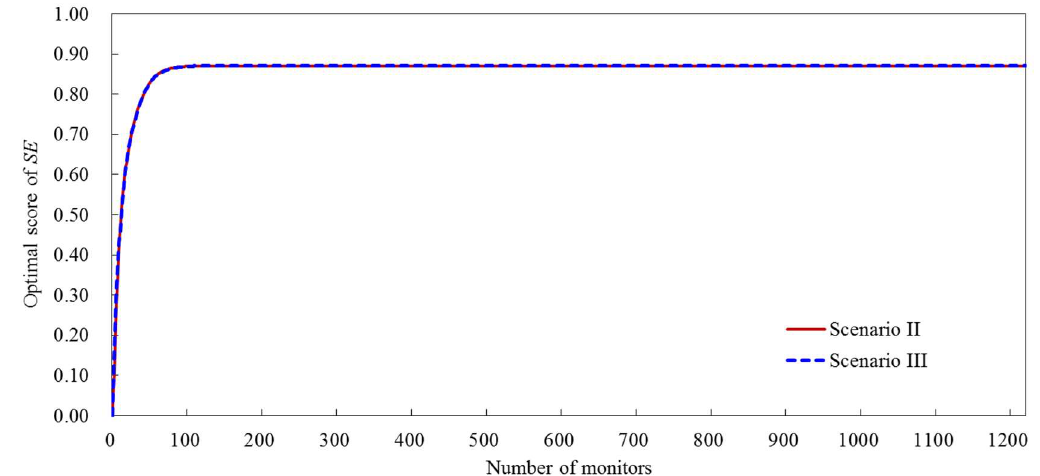
Figure 7. Optimal SE scores for AQMNs with different numbers of monitors. The red line represents the result of Scenario II; the blue line represents the result of Scenario III.